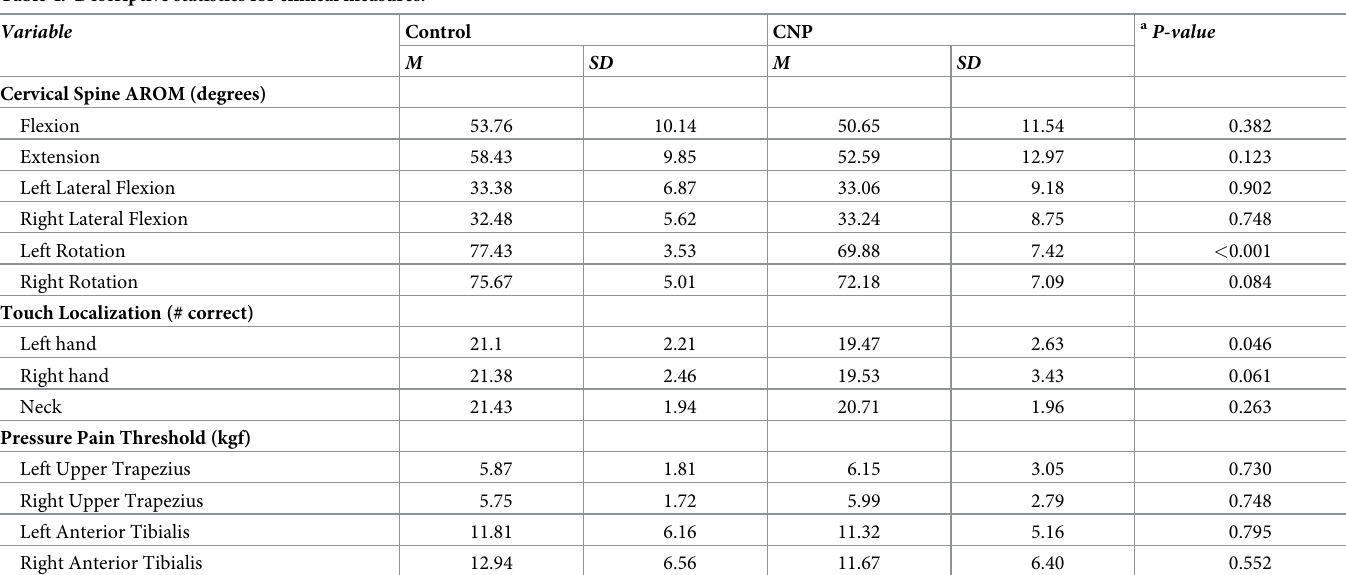
Table 4. Descriptive statistics for clinical measures.